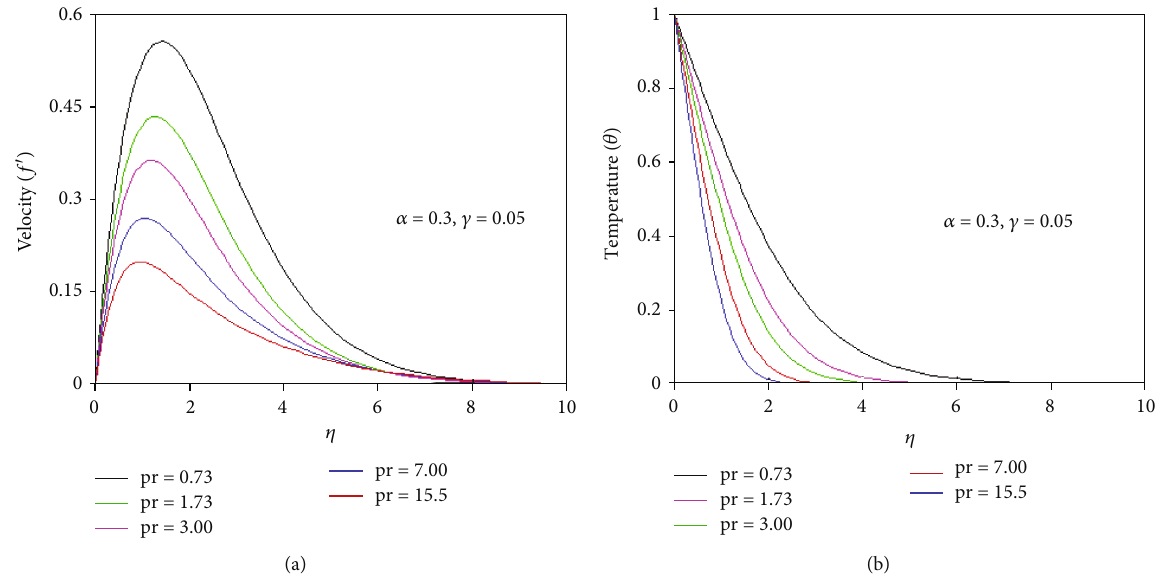
Figure 7: Variation of (a) the pro fi les of velocity ð f ′ Þ and (b) the dispensation of temperature ð θ Þ for various Prandtl numbers, Pr against dimensionless distance η while γ = 0 : 05 and α = 0 : 3 .